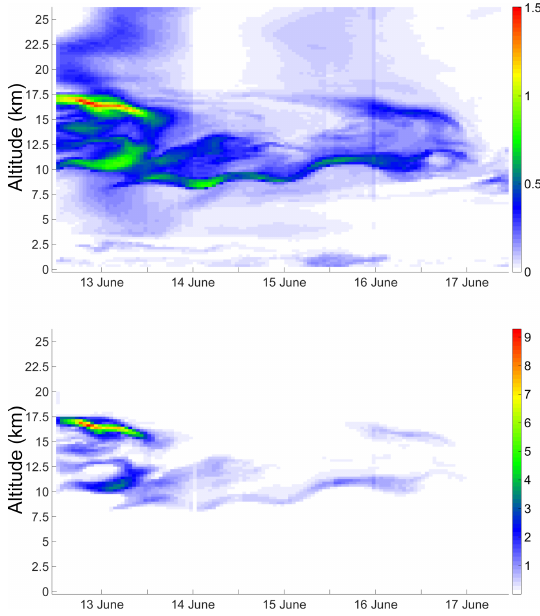
Figure 5. Reconstructed SO 2 emission rates (kgm − 1 s − 1 ) for the Nabro eruption in June 2011. Emission rates were obtained by ap- plying the mean rule (top) and the product rule (bottom) weight- updating schemes of the proposed inversion approach (see text for